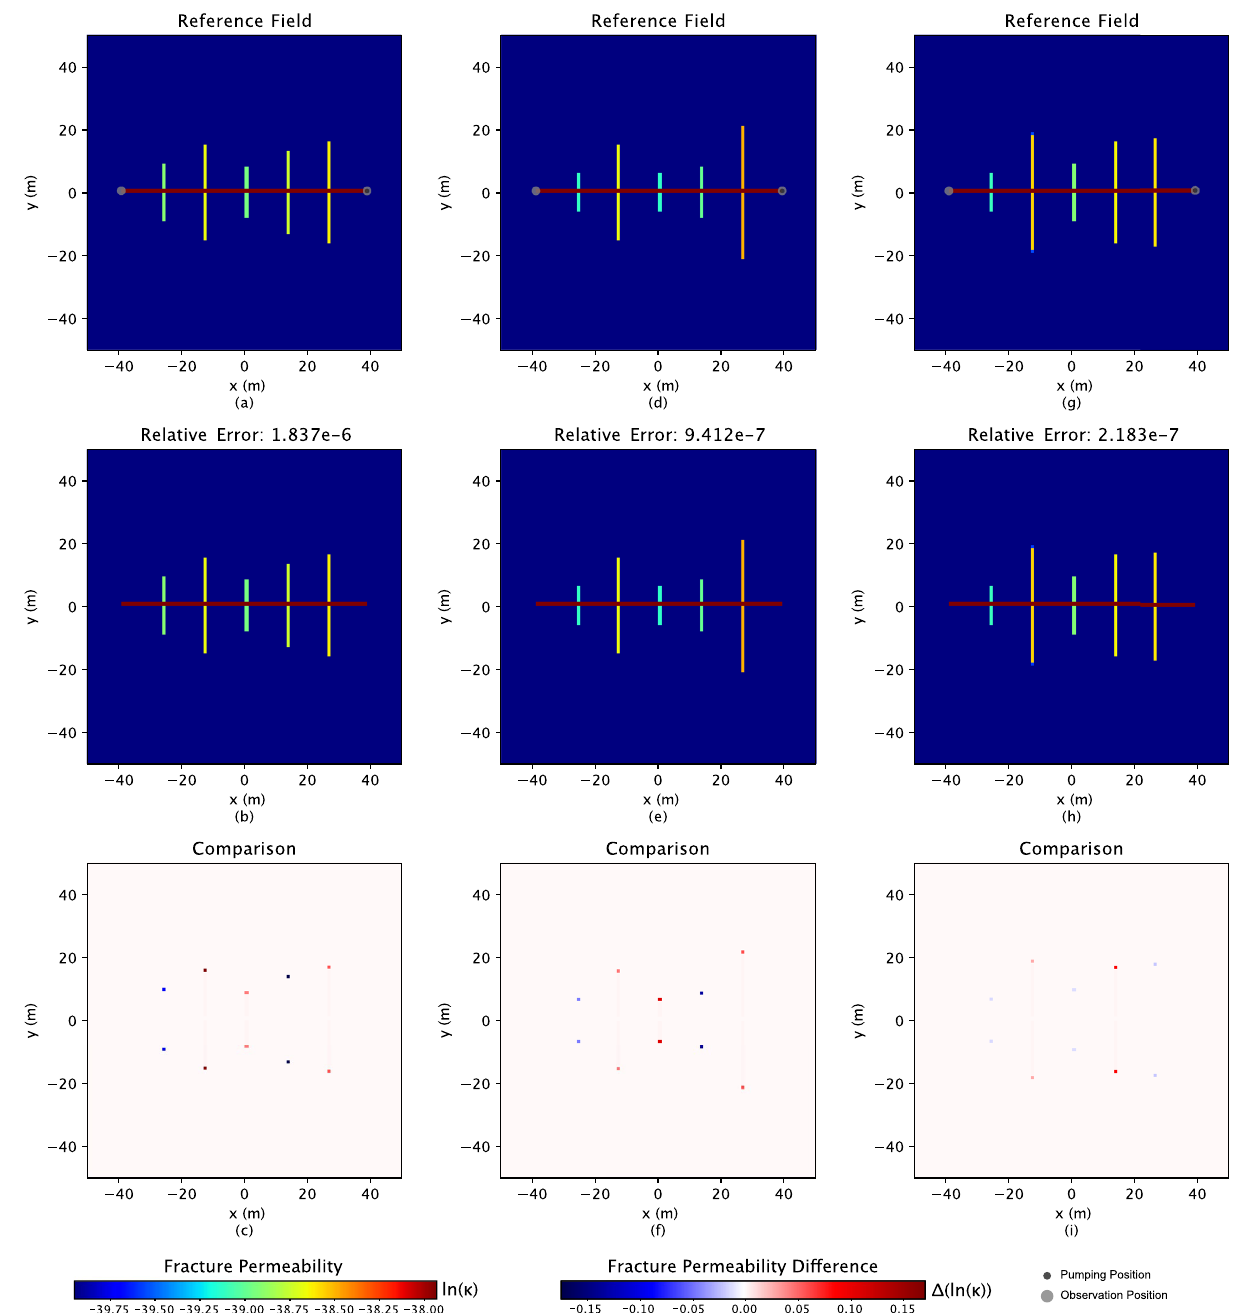
Figure 5. Three hydraulic fracture reference conductivity fields are shown in subfigures ( a ), ( d ), and ( g ). The two grey dots in the first row represent the positions for observation, and the black dot illustrates the gas pumping position. The corresponding inverse results are shown in the second row, subfigures ( b ), ( e ), and ( h ). The permeability shows on the ln scale. The relative errors above inverse figures represent the difference between related reference and simulation figures. The last row shows the difference between the related reference fields and the inverse results. The color bars only apply for the hydraulic fractures, and the permeability for the matrix and well are − 52.16 and − 24.53 ( ln scale),